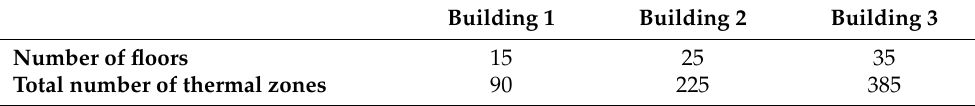
Table 3. Building parameters.